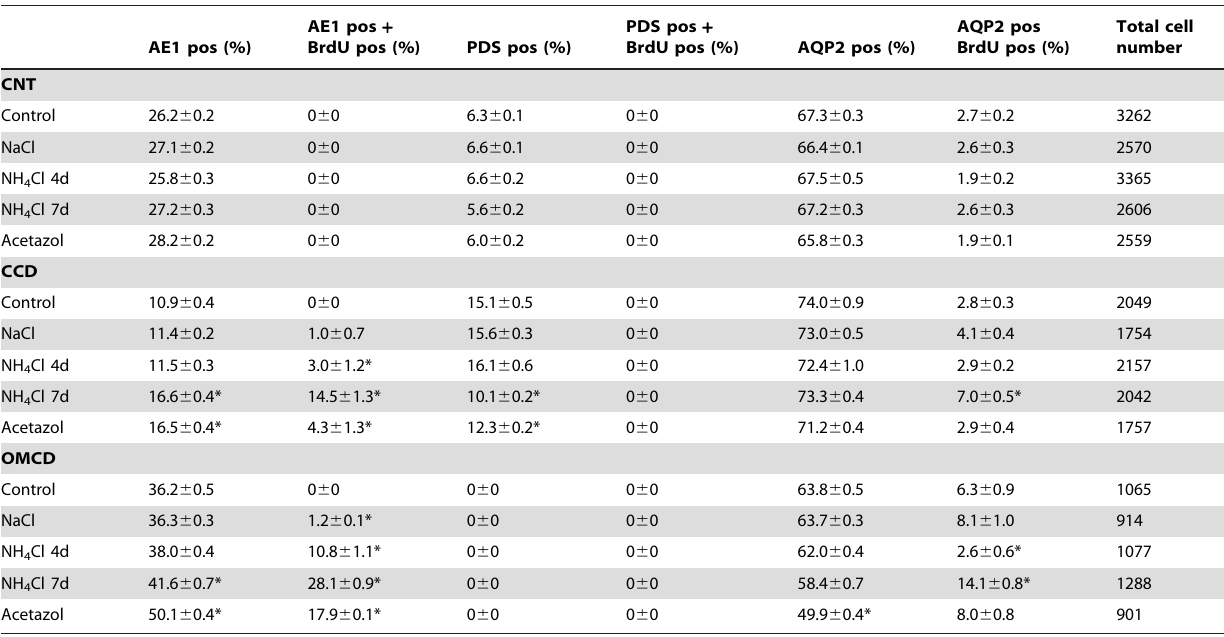
Data are given as mean 6 SEM. *marks significant difference between control and treated